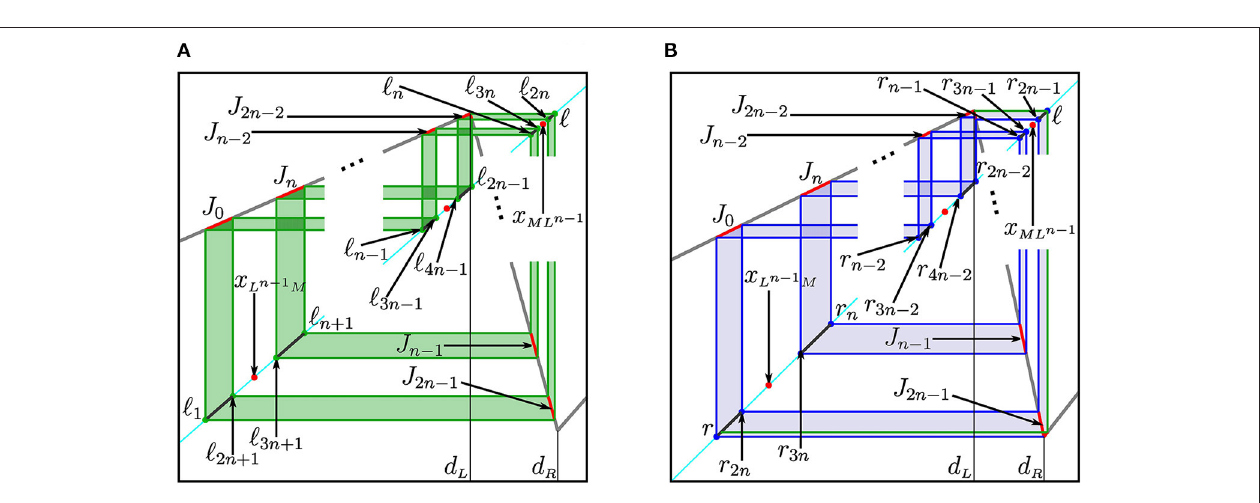
i = 0, 2 n − 2, constituting Q 2 n are bounded by ℓ i + 1 = r i